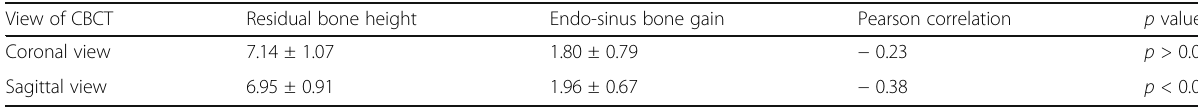
Table 3 Correlation between the residual bone height and endo-sinus bone gain View of